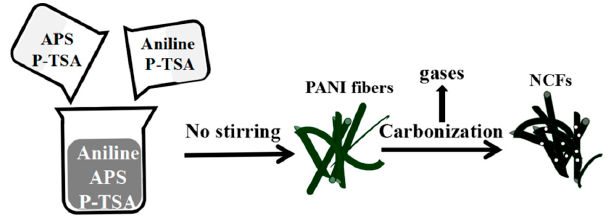
Figure 1. The schematic diagram of the preparation of NCFs.